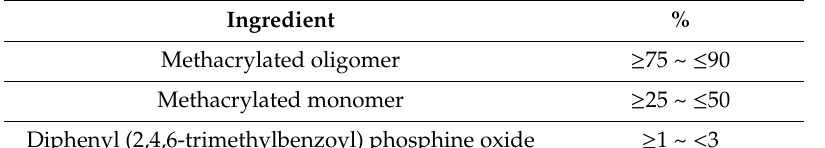
Table 2. Composition of Grey Resin V3.